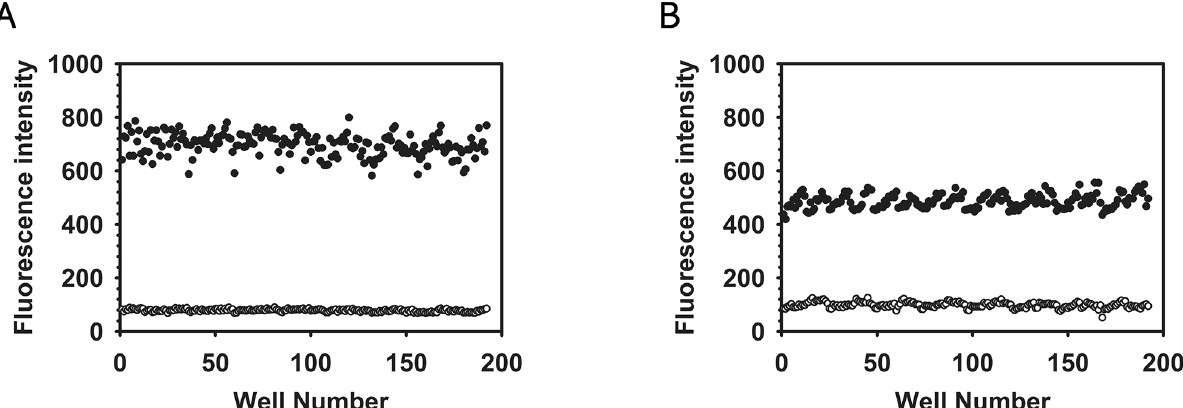
Fig 3. Validation of SYTOX Green assay robustness. To test the robustness of the SYTOX Green assay, the Z ’ -factor was calculated from fluorescence intensity data from a 384-well plate where half of the wells contained 0.1% DMSO (negative control, open circles) and the remaining wells contained 10X MIC lysostaphin (A) or 10X MIC nisin (B) (positive controls, solid circles). Fluorescence was measured with an excitation wavelength of 485 nm and an emission wavelength of 525 nm after incubation in the dark for 1 h. The Z ’ -factors for each assay were 0.767 (A) and 0.712 (B).